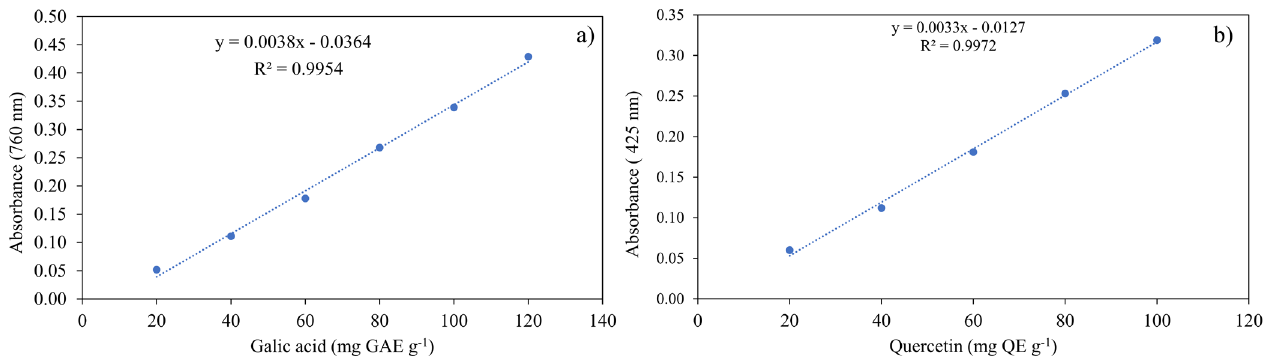
FIGURE 4 - Analytical curve for the analysis of phenols and flavonoids. a) Gallic acid with concentrations of 20, 40, 60, 80, 100 and 120 mg GAE g -1 analyzed at 765 nm, b) Quercitina with concentrations of 20, 40, 60, 80, 100 mg QE g -1 analyzed at 420